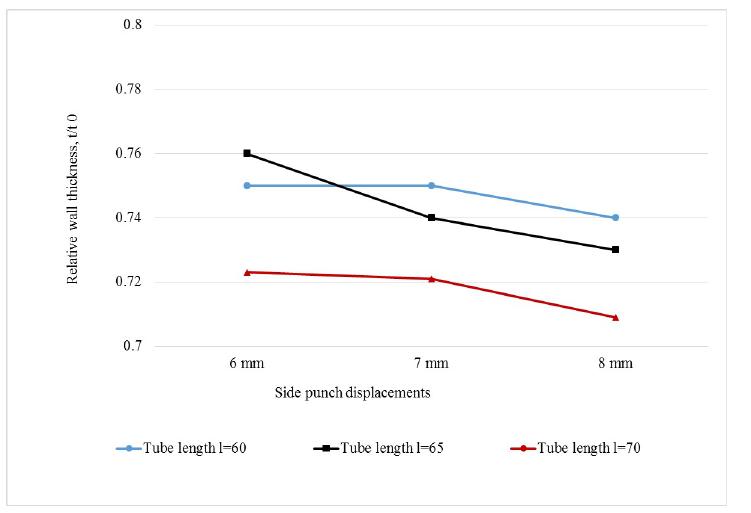
Fig 13. Simulation results of minimum